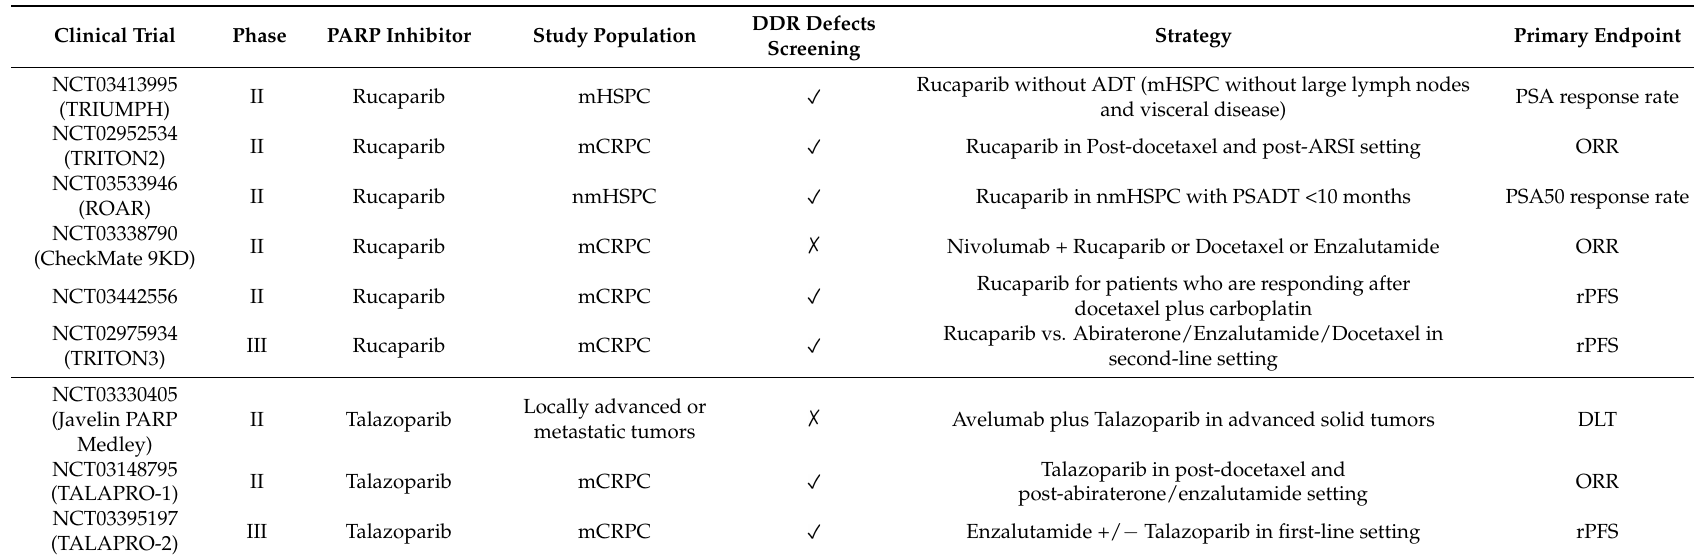
Table 3. Ongoing clinical trials evaluating PARP inhibitors in prostate